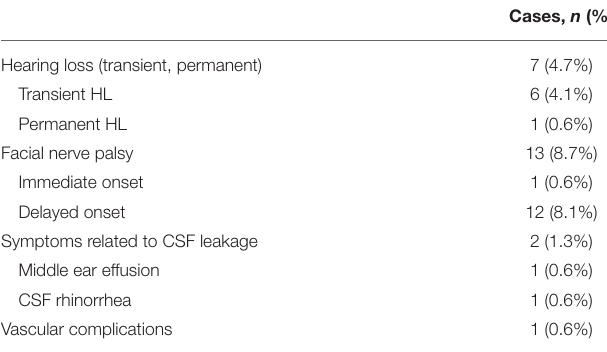
TABLE 4 | Post-operative complications of patients who underwent keyhole MVD for HFS.